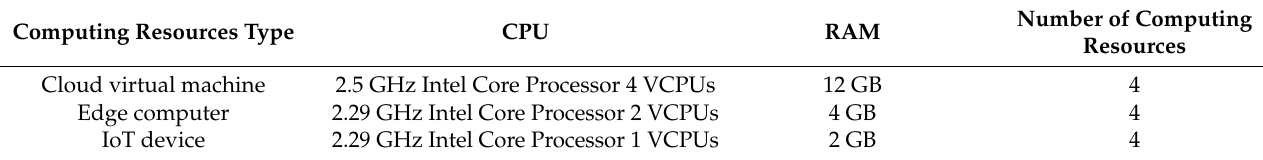
Table 3. System configurations of the computing resources.